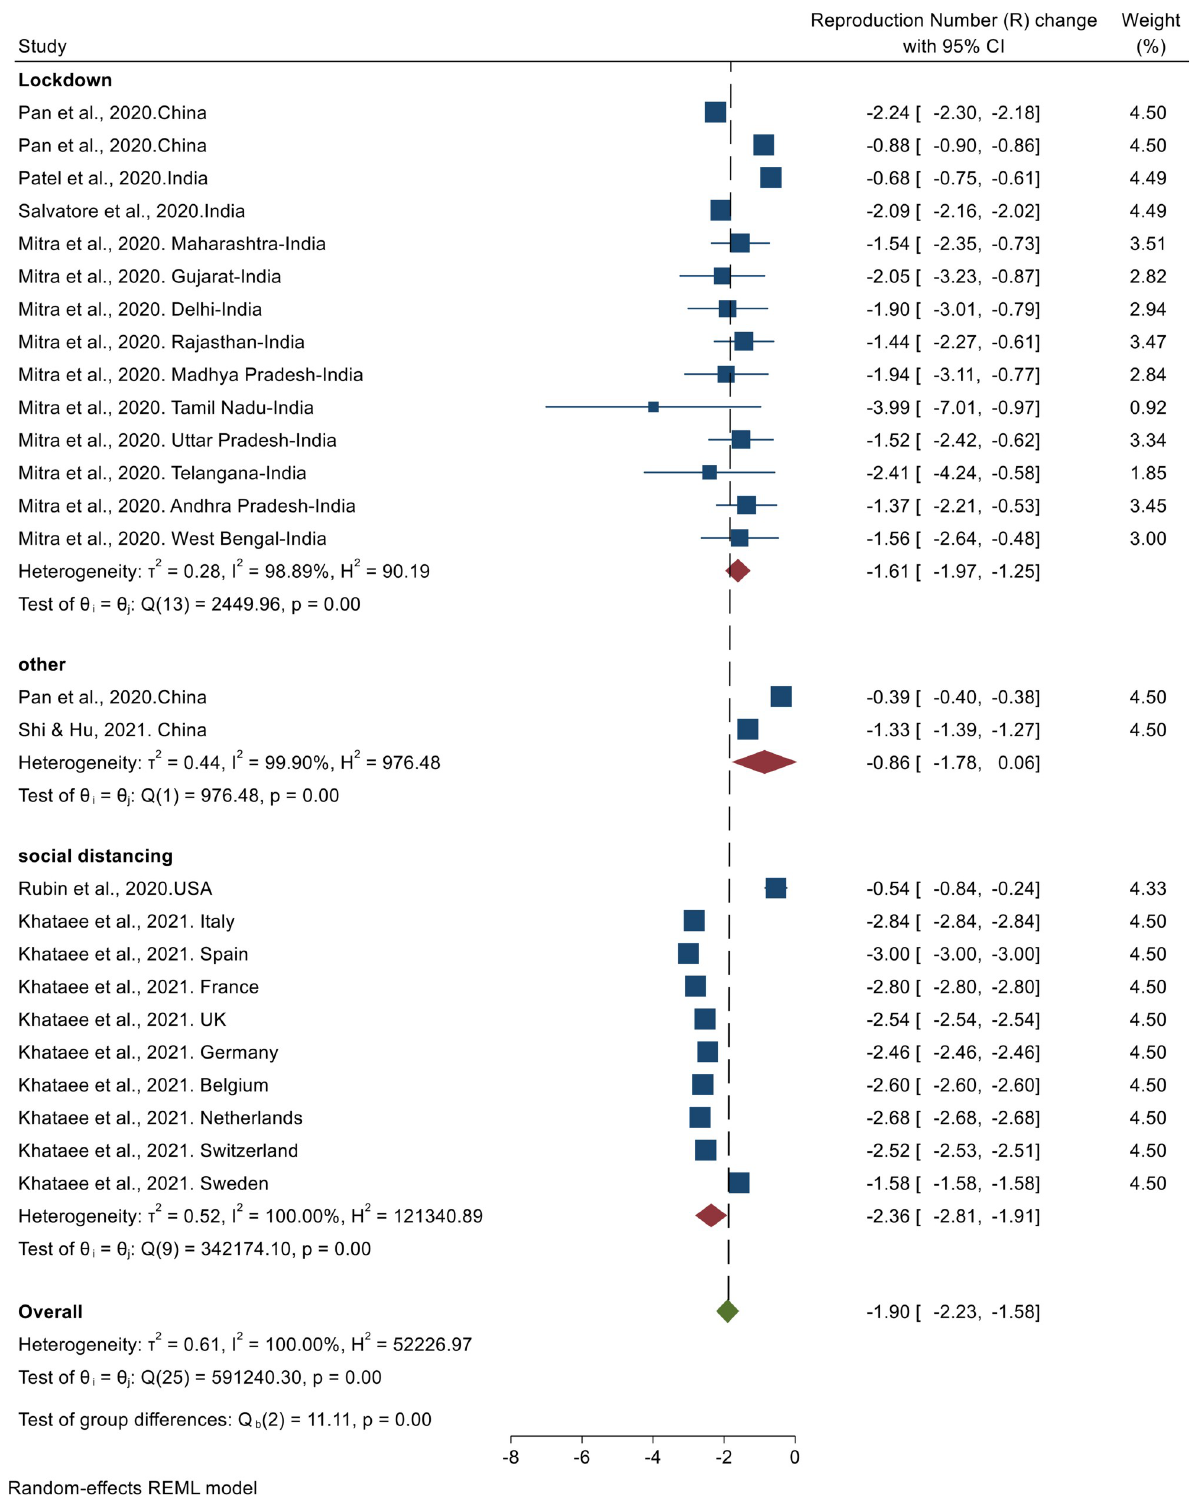
PLOS ONE | https://doi.org/10.1371/journal.pone.0260371 November23,